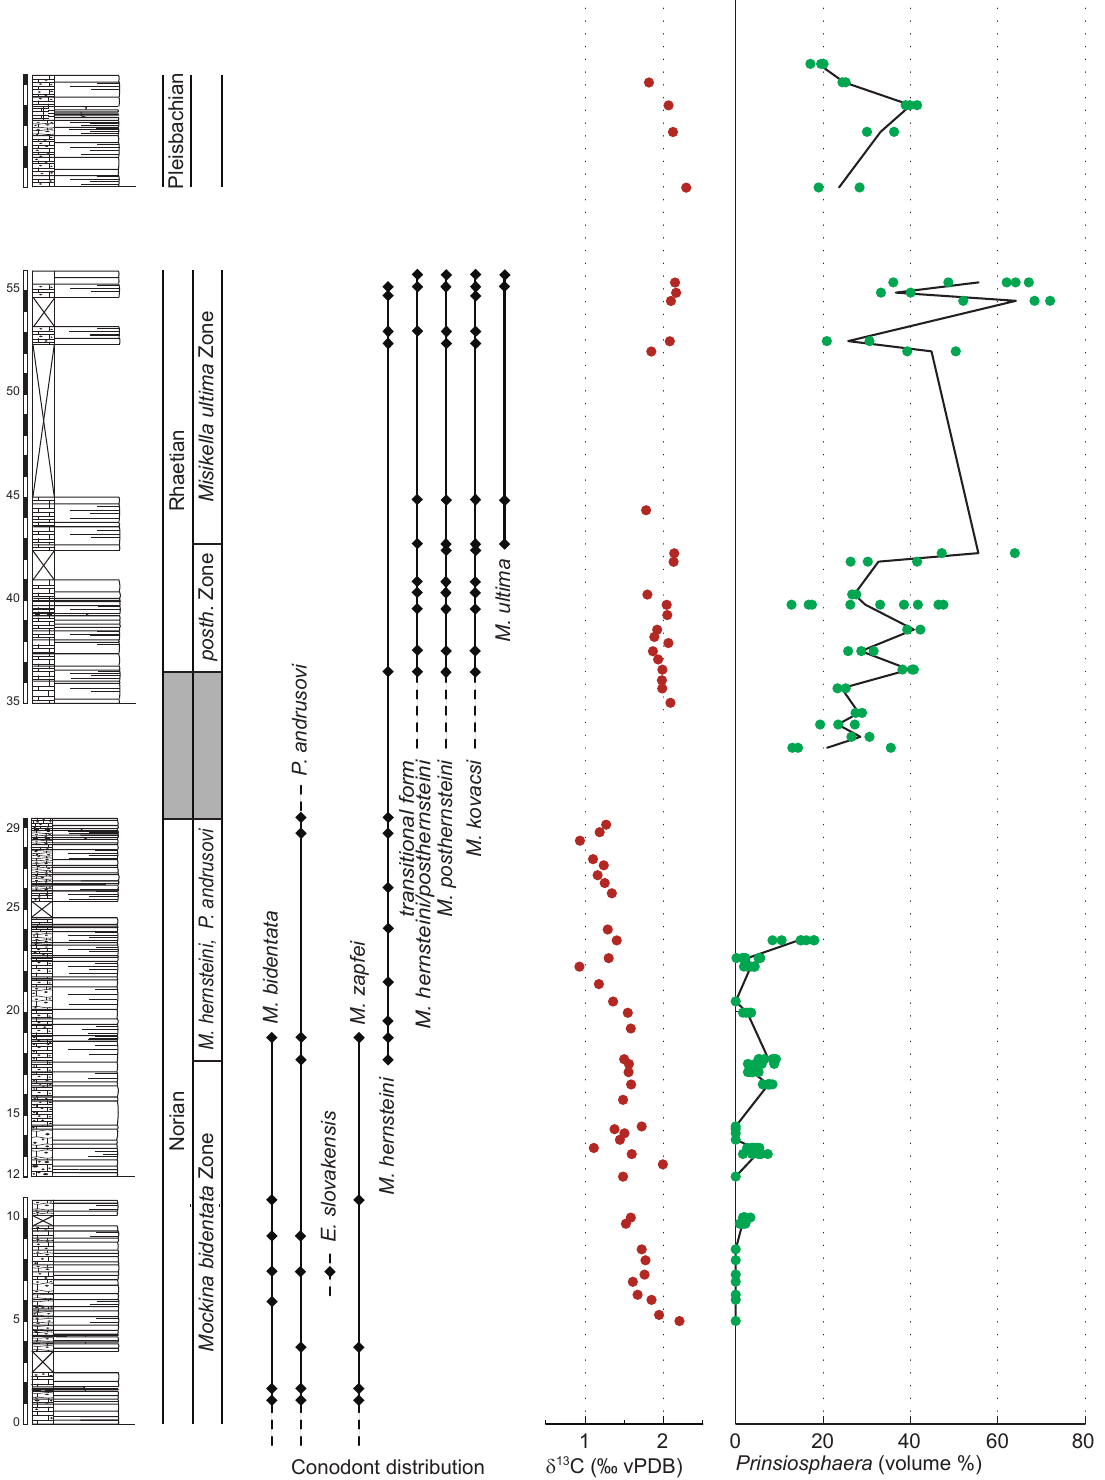
Fig. 2. Stratigraphy, stable carbon isotopes from bulk carbonate and volume proportion of calcareous nannofossils at Pizzo Mondello (Sica- nian Basin, Sicily). The black line connects mean volume proportions of nannofossils. Biostratigraphy from Mazza et al. (2012) and Preto et al. (2012). Conodont biozones according to Kozur and Mock (1991). Lithological symbols as in Fig.